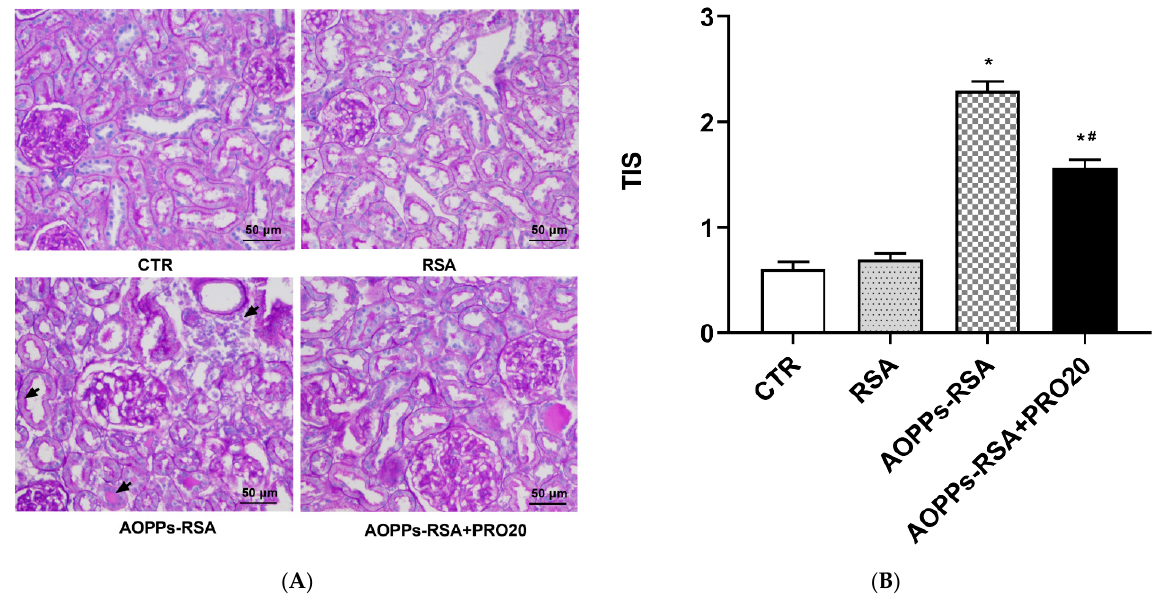
Figure 1. Histological evaluation of renal tissue and tubular injury. Notes: ( A ) Renal cortex sections were stained with periodic acid–Schiff (PAS) at the 4th week. ( B ) Quantification of tubulointerstitial injury scores (TIS) based on histology. At least 10 fields per rat were qualitatively analyzed (3 rats per group). The results were presented as means ± SEM. CTR, control; RSA, rat serum albumin; AOPPs, advanced oxidation protein products. * p < 0.05, compared to the CTR group; # p < 0.05, compared to the AOPPs-RSA group.